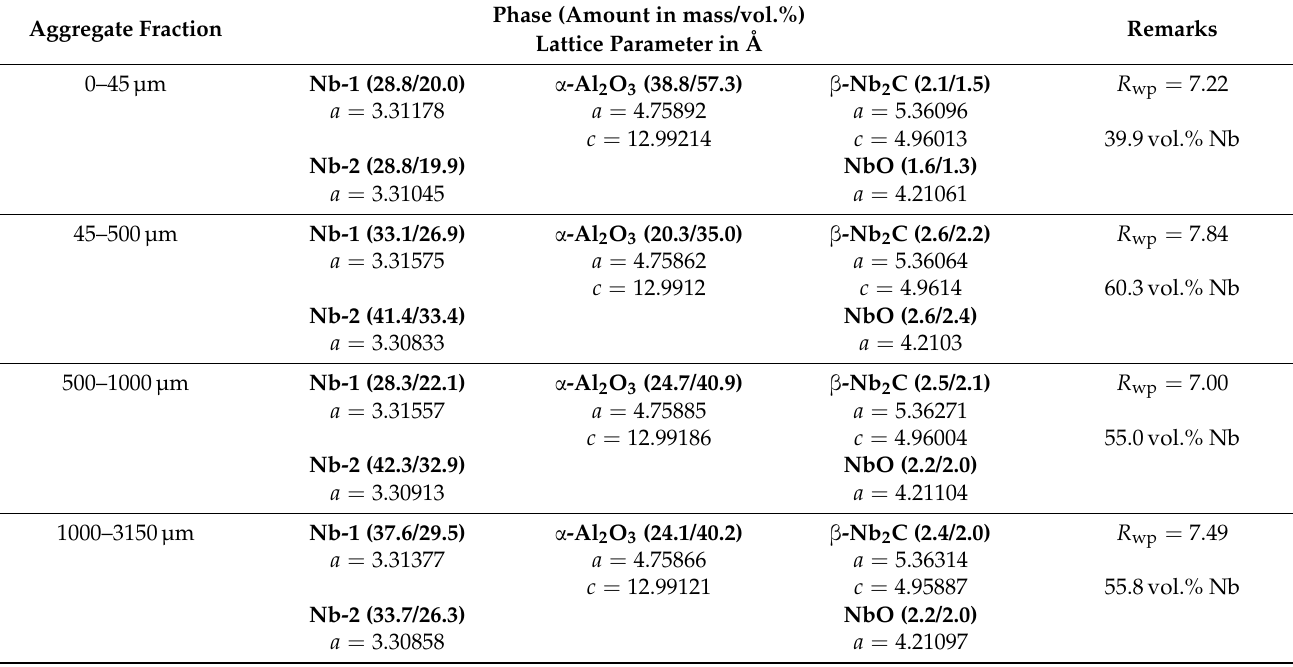
Table 5. Results of the Rietveld refinement of the four aggregate fractions 0–45µm, 45–500µm, 500–1000µm and 1000–3150µm. The overall fit quality of the Rietveld refinement can be judged with the presented weighted profile R- values R wp . Phase (Amount in Aggregate Fraction